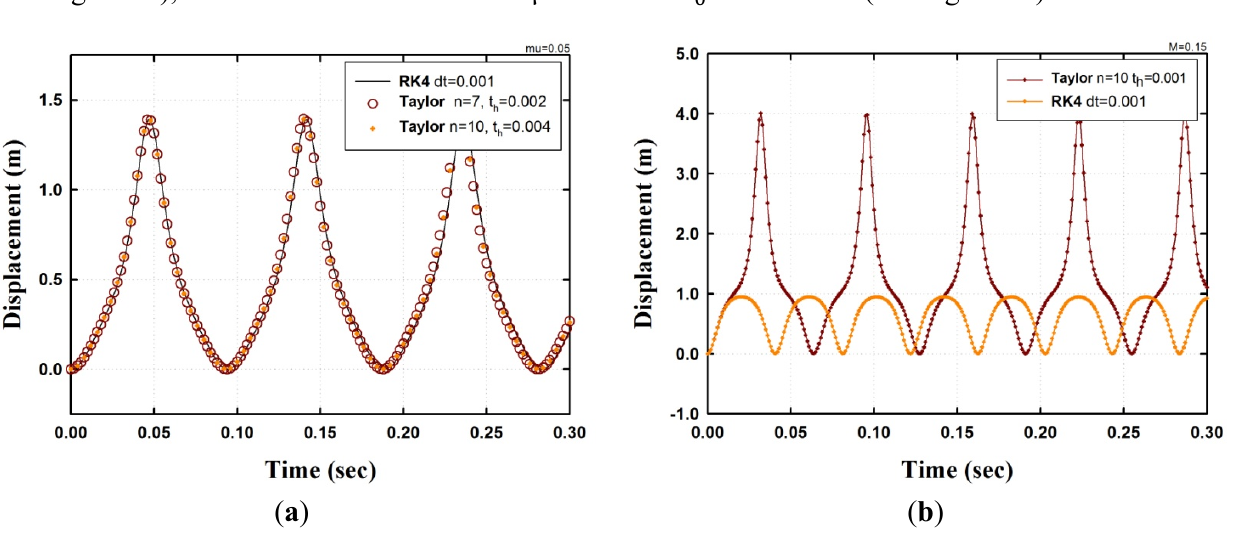
(cid:3404) 3300 kN (cid:2868)